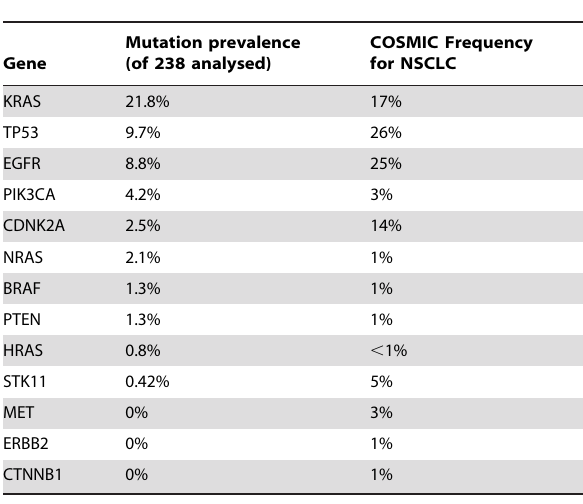
Table 5. Mutation prevalence in NCT00890825 NSCLC patients using MALDI-TOF panel compared to COSMIC NSCLC